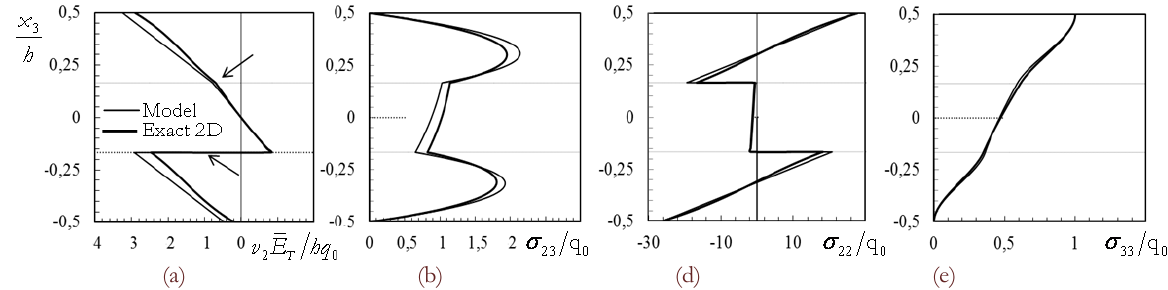
   sin q q x L . 0 2